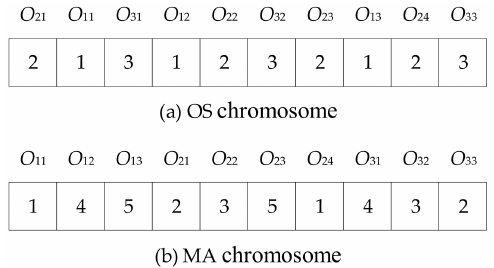
Figure 7. A chromosome example for the scheduling